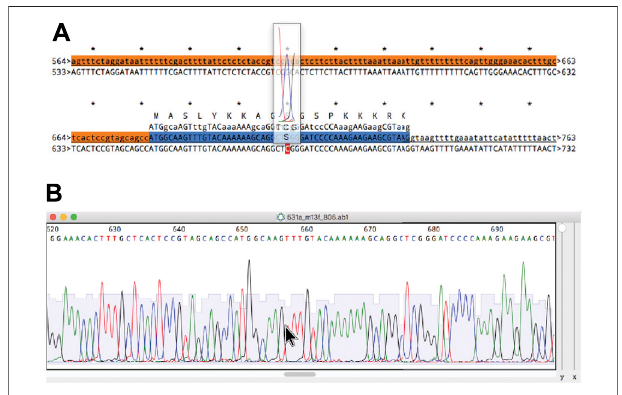
FIGURE 10 | Alignment of a reference sequence to a Sanger sequence. (A) An alignment of a reference sequence ( fi rst line) to an abi output of a Sangersequencingreaction(secondline).Themouseisplacedoverbase677 in the abi sequence to show a fl oating window containing the abi data. (B) The source abi trace fi le of the alignment in (A)